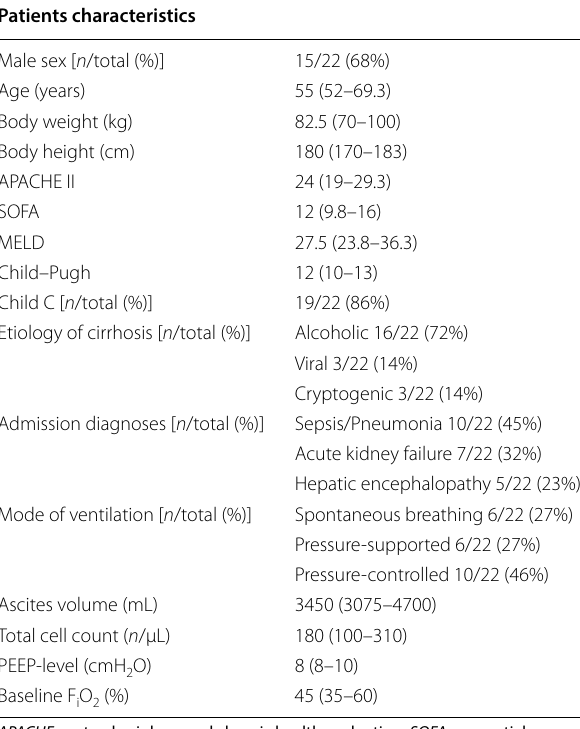
Table 1 Patients baseline characteristics and clinical